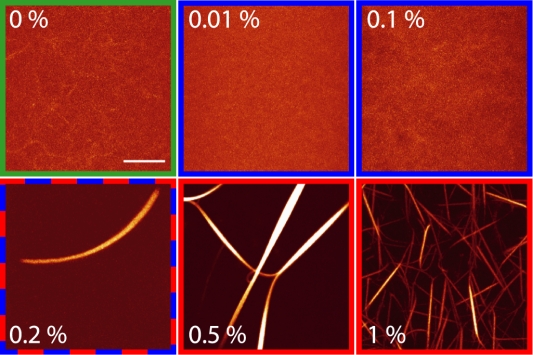
Methylcellulose induced actin bundle formation.Confocal micrographs of F-actin solutions (9.5 µM) with increasing methylcellulose concentrations. Bundles appear at a MC concentration of 0.2% (w/v), below this concentration only single filaments can be observed. At 1% MC, much more bundles occur which seem to be thinner than those formed at lower MC concentrations (scale bar: 10 µm). The color code corresponds to the three regimes depicted in figure 2.